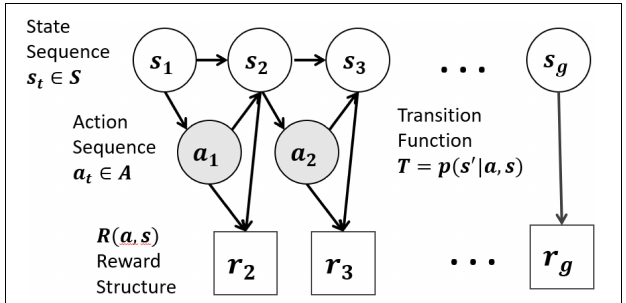
FIGURE 3 | Markov decision process models a path through a problem space as a sequence of actions taken, where each action results in a cost or benefit (the rewards) and changes the state of the problem in some way, reflected in the state space. In many situations there is a goal state s g which results in a large, positive